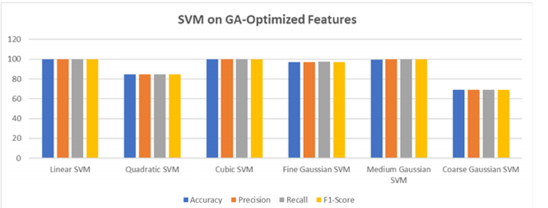
Figure 10. Graphical comparison of various SVM kernels on GA-optimized features